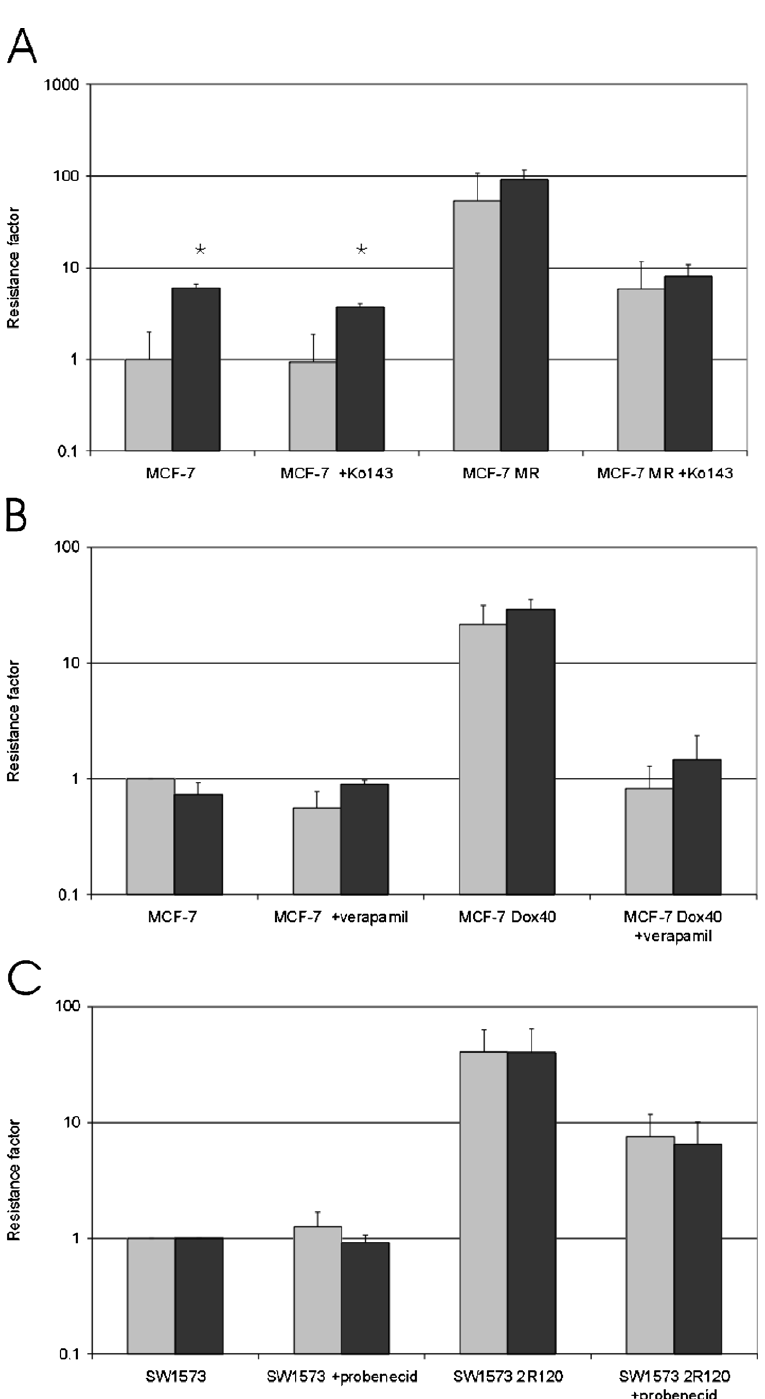
Fig. 1. Resistance factors of cells cultured with doxorubicin or mitoxantrone under normoxia and hypoxia. A: MCF-7 and MCF-7 MR, overex- pressing BCRP, in presence of mitoxantrone, B: MCF-7 and MCF-7 Dox40, overexpressing P-gp, in presence of doxorubicin, C: SW1573 and SW1573 2R120, overexpressing MRP1, in presence of doxorubicine. Gray boxes: normoxia, dark boxes: hypoxia. Results shown are means ± SD of three experiments. Asterisk indicates significant differences ( P (cid:1) 0 .